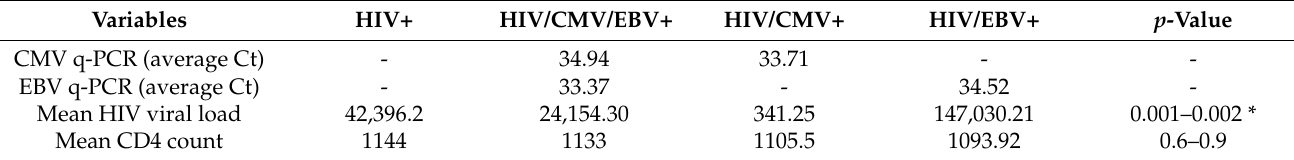
Table 2. Virological and clinical features of HIV mono- and HIV/CMV/EBV co-infected groups. The table shows the average Ct values for EBV and CMV in co-infected groups, as well as CD4 count and HIV viral loads in mono- and co-infected groups The p -values are given in the last column, where a significant p -value ( p < 0.05) is indicated by